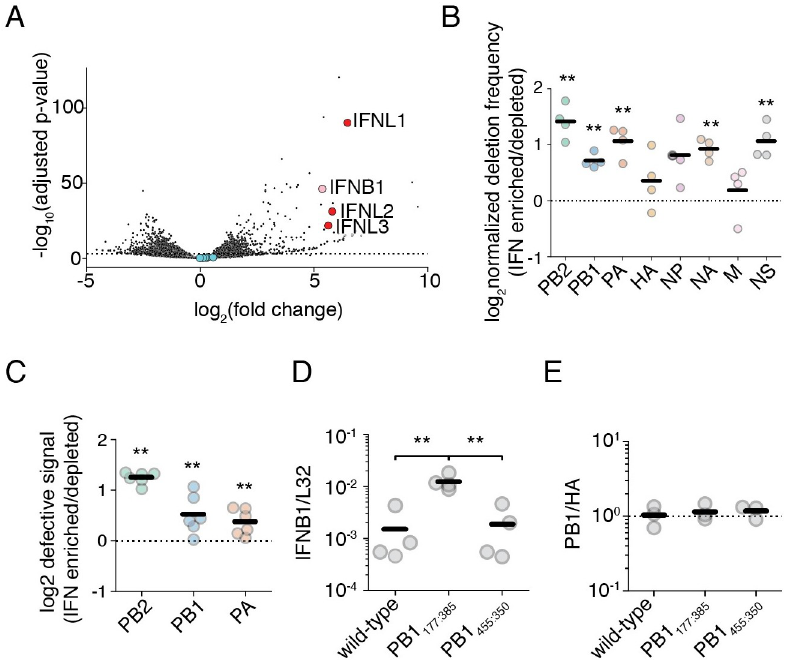
Fig 4. Interferon-producing cells are enriched for defective influenza segments. (A) Differential gene expression analysis on interferon-enriched and -depleted populations. An A549 type I interferon reporter cell line was infected at an MOI of 0.1 and sorted using magnetic-activated cell sorting 14 hours post infection. Fold-change calculated as mRNA abundance in interferon-enriched/interferon-depleted datasets. Type I interferon gene IFNB1 labeled in pink, the type III interferon genes IFNL1–3 in red, and influenza transcripts in blue. n = 4. Populations used are described in S6 Fig. Full table of differentially expressed genes in S2 File (B) The fraction of junction-spanning fragments per influenza segment was compared between interferon-enriched and depleted populations. Values above the dotted line indicate segments where deletions are co-enriched with interferon. Asterisks represent significant enrichment, one- sample one-tailed t-test. Stochastic detection of deletions demonstrated in S7 and S8 Figs. Raw data in S9 Fig, mapping depth in S10 Fig n = 4. (C) qPCR validation of (B) for the three polymerase segments using the assay as described in S11 Fig. Values above the dotted line indicate co-enrichment of deletions with interferon. Asterisks represent significant enrichment, one-sample one-tailed t-test. Triplicate measurements were made of two biological replicates. n = 6. (D) Different PB1 deletions induce different amounts of interferon. A549 cells were infected by the indicated variants at an MOI of 0.5. IFNB1 transcripts normalized to the housekeeping control L32 were measured 8h post infection by qPCR. Asterisks represent significantly different values in all pairwise comparisons, two-tailed t-test. n = 4. Measurements of influenza transcription shown in S11 Fig. (E) Different PB1 deletions package to similar ratios as wild-type PB1. Ratio of PB1 to HA, normalized to wild-type, in viral stocks as measured by qPCR. Dotted line represents average wild-type ratio. No values significantly diverged from wild-type, two-tailed t-test, p < 0.05. n = 3. For panels (B) , (C) , (D) , and (E) individual points are individual measurements, lines are mean values. For panels (B) , (C) , and (D) significance was calculated using Benjamini-Hochberg correction at an FDR of